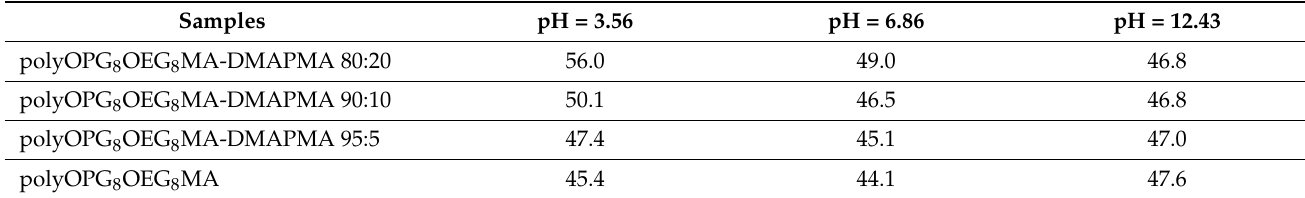
Table 5. Phase separation temperatures for solution of polyOPG 8 OEG 8 MA-DMAPMA at different pH